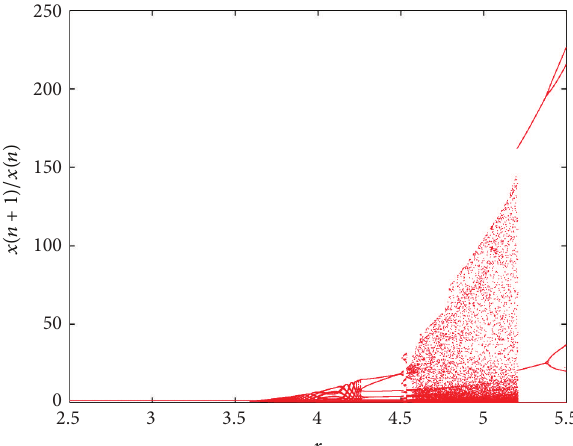
Figure 1: Behavior of the solutions of (7), where 𝛼 = 0.00195789 , 𝛽